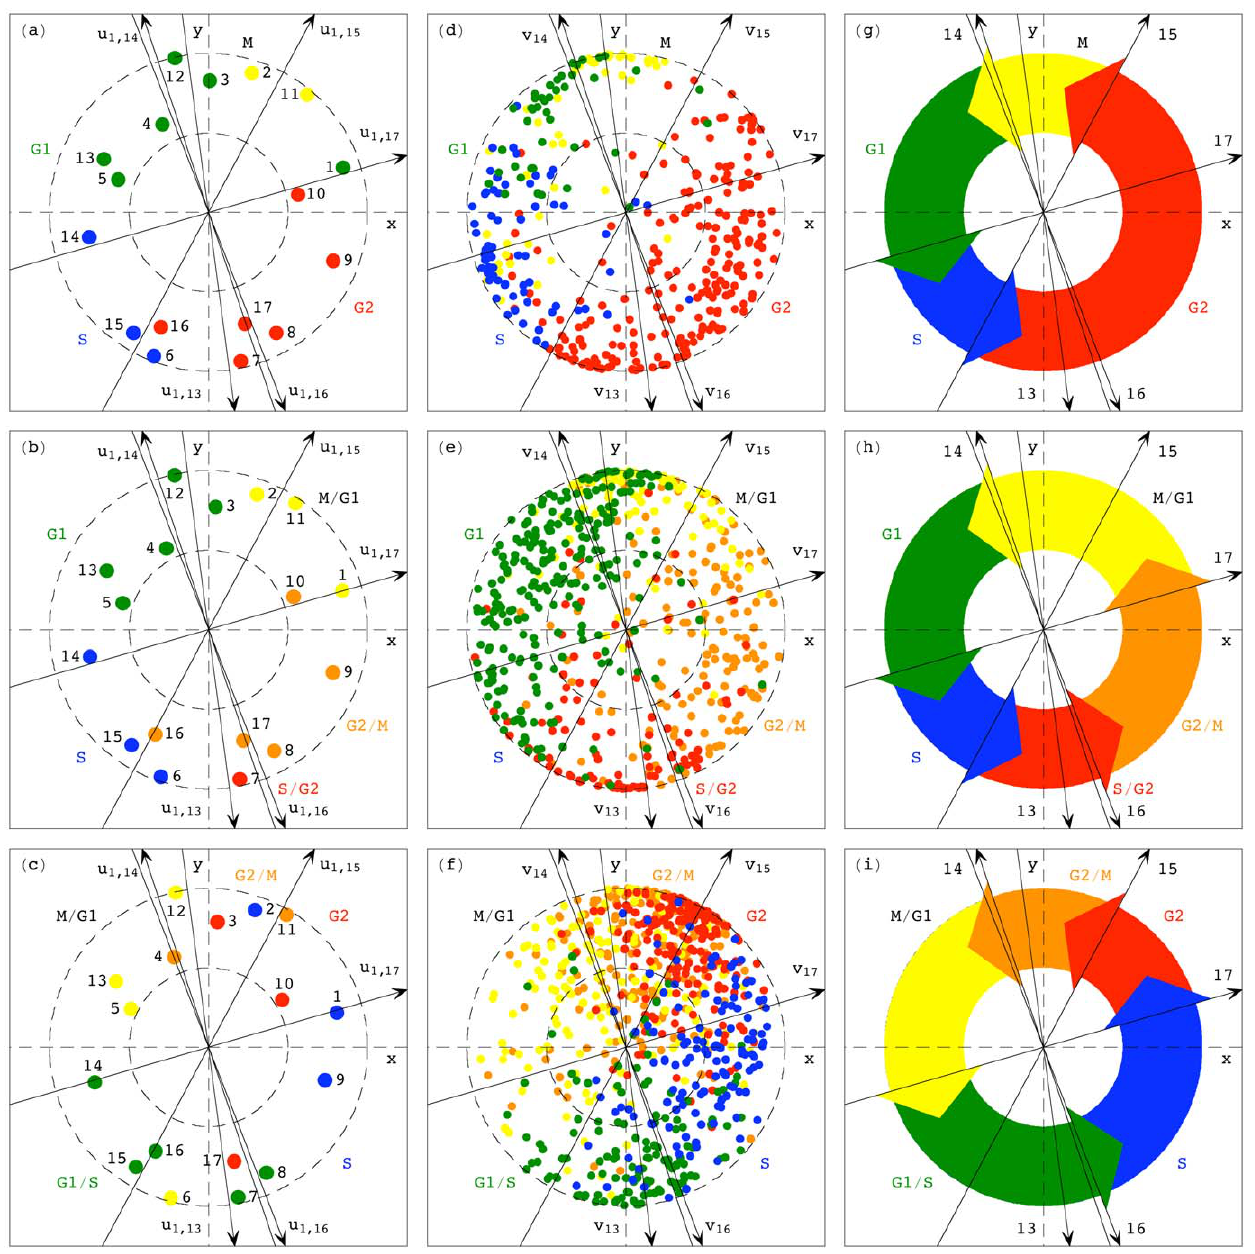
Figure 3. Common HO GSVD subspace represents similar cell-cycle oscillations. ( a – c ) S. pombe , S. cerevisiae and human array expression, projected from the five-dimensional common HO GSVD subspace onto the two-dimensional subspace that approximates it (Sections 2.3 and 2.4 in Appendix S1). The arrays are color-coded according to their previous cell-cycle classification [15–18]. The arrows describe the projections of the k ~ 13, ... ,17 arraylets of each dataset. The dashed unit and half-unit circles outline 100% and 50% of added-up (rather than canceled-out) contributions of these five arraylets to the overall projected expression. ( d – f ) Expression of 380, 641 and 787 cell cycle-regulated genes of S. pombe , S. cerevisiae and human, respectively, color-coded according to previous classifications. ( g – i ) The HO GSVD pictures of the S. pombe , S. cerevisiae